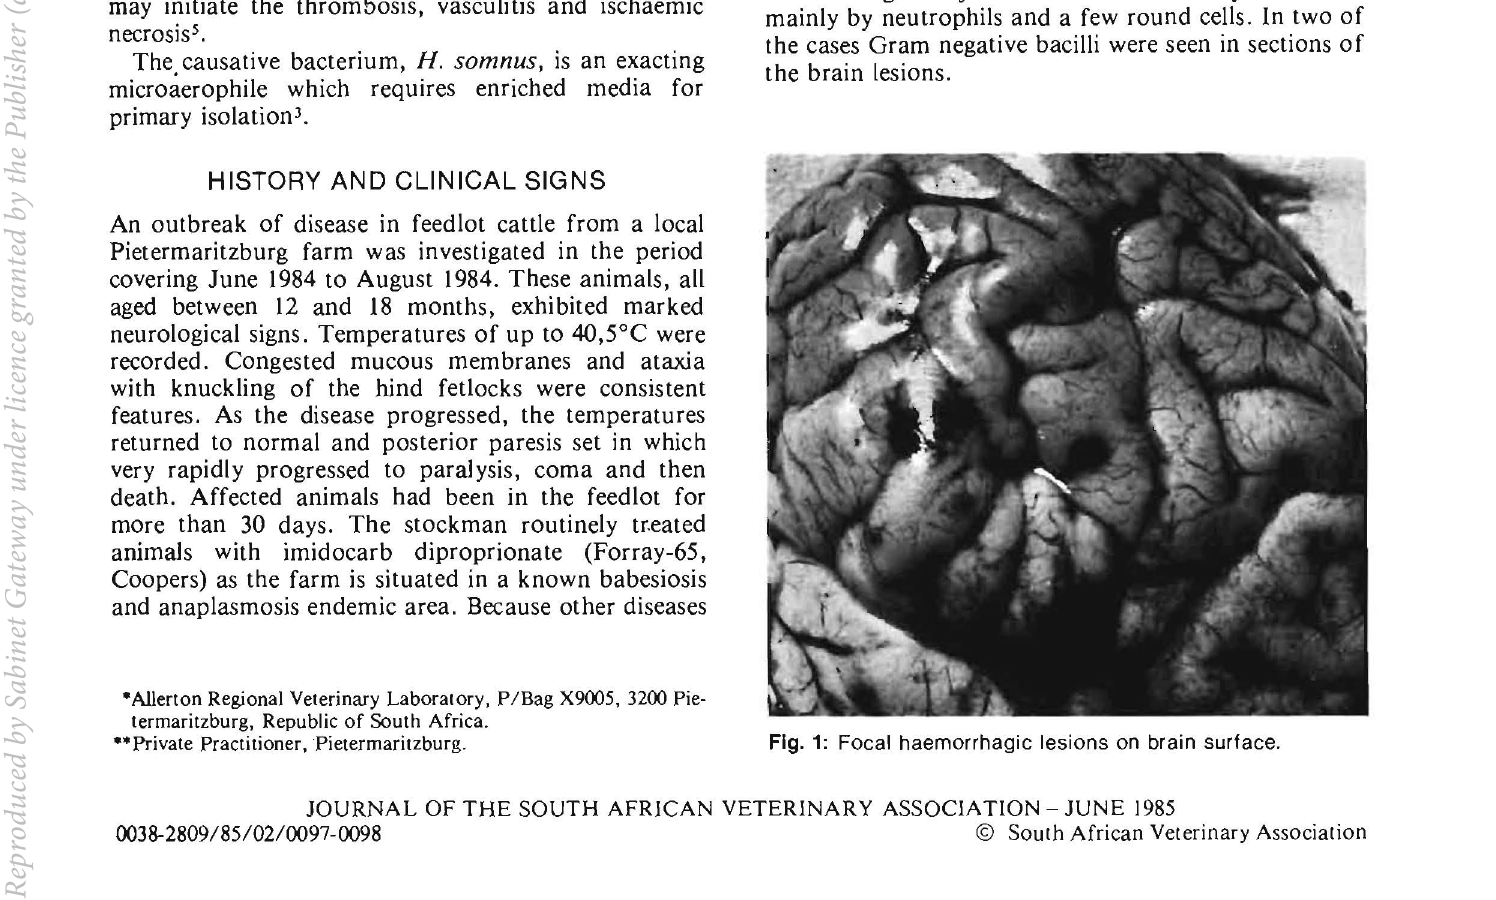
FIg. 1: Focal haemorrhagic lesions on brain